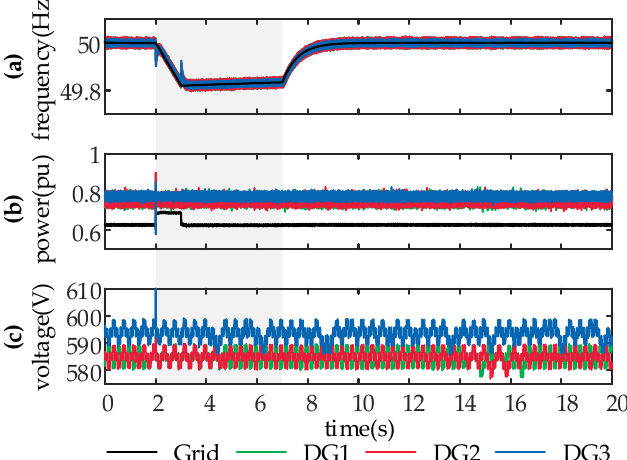
Figure 10. Responses to a short circuit fault when conventional PV systems are applied as DG1–DG3: ( a ) Frequency response; ( b ) output active power; ( c ) dc link voltage of the inverter.